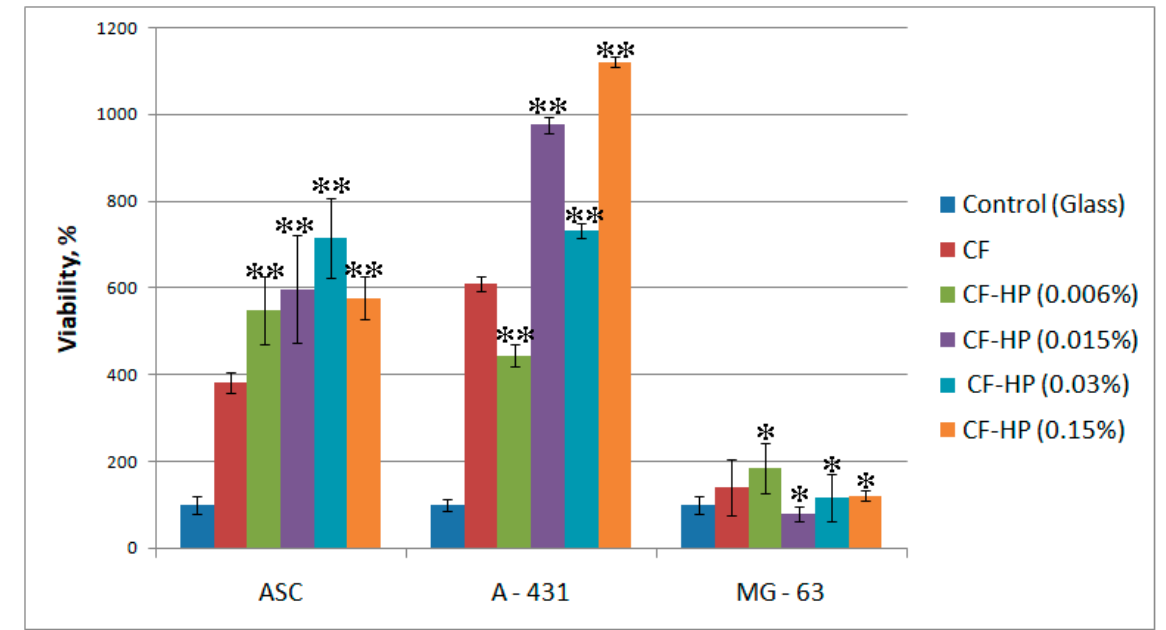
Figure 7. Citotoxity study (MTT-test) with ASCs, A-431 and MG-63 cells on collagen fibrils after different HP treatment: CF — collagen fibrils before treatment; CF-HP (0.006%) — collagen fibrils after HP treatment with concentration 0.006%; CF-HP (0.015%) — collagen fibrils after HP treatment with concentration 0.015%; CF-HP (0.03%) — collagen fibrils after HP treatment with concentration 0.03%; CF-HP (0.15%) – collagen fibrils after HP treatment with concentration 0.15%. (n = 5: * — p < 0.01, ** — p < 0.05 compared with the unmodified CF).